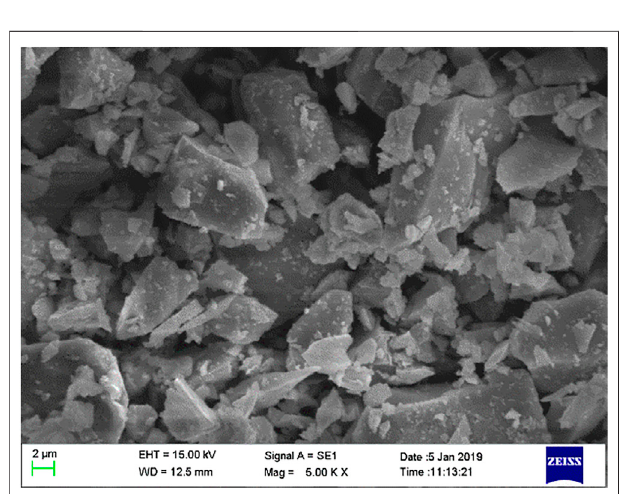
FIGURE3| SEMimagesofcementandSCMs,groundgranulatedblast- furnace